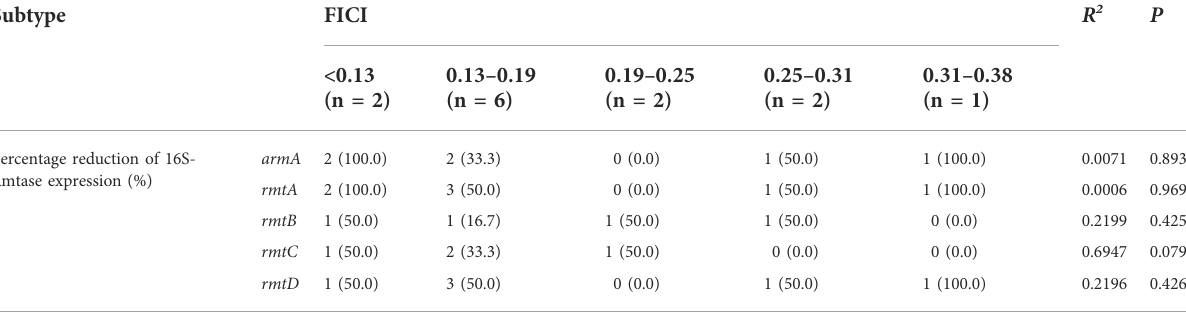
TABLE 5 Correlation analysis between fractional inhibitory concentration index (FICI) values and 16S rRNA methyltransferase (16S-Rmtase) mRNA expression in 13 clinical isolates of Pseudomonas aeruginosa . Subtype